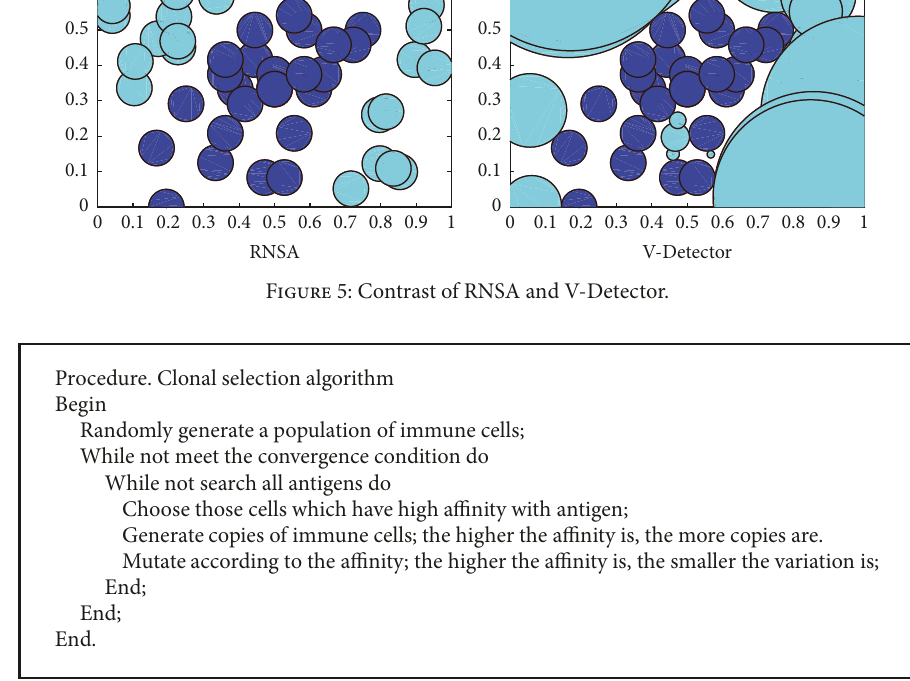
Algorithm 2: The process of clonal selection